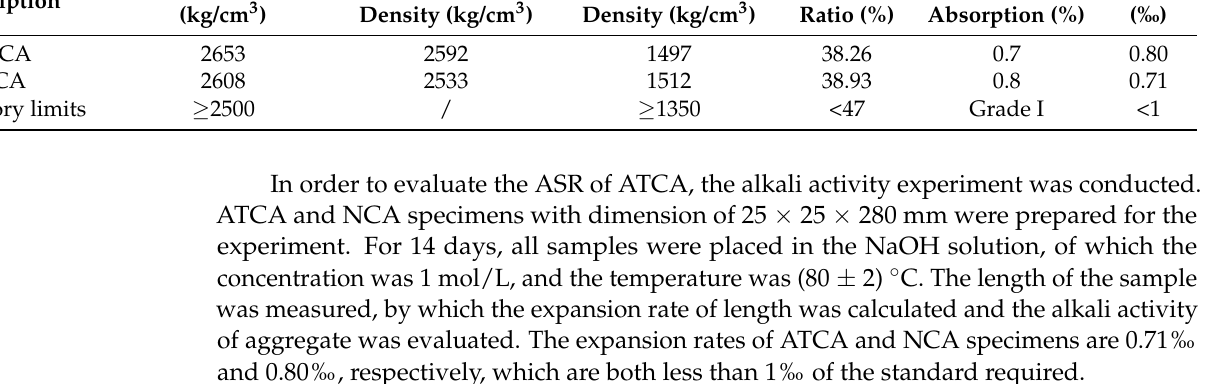
Table 4. The test results of the quality of ATCA and